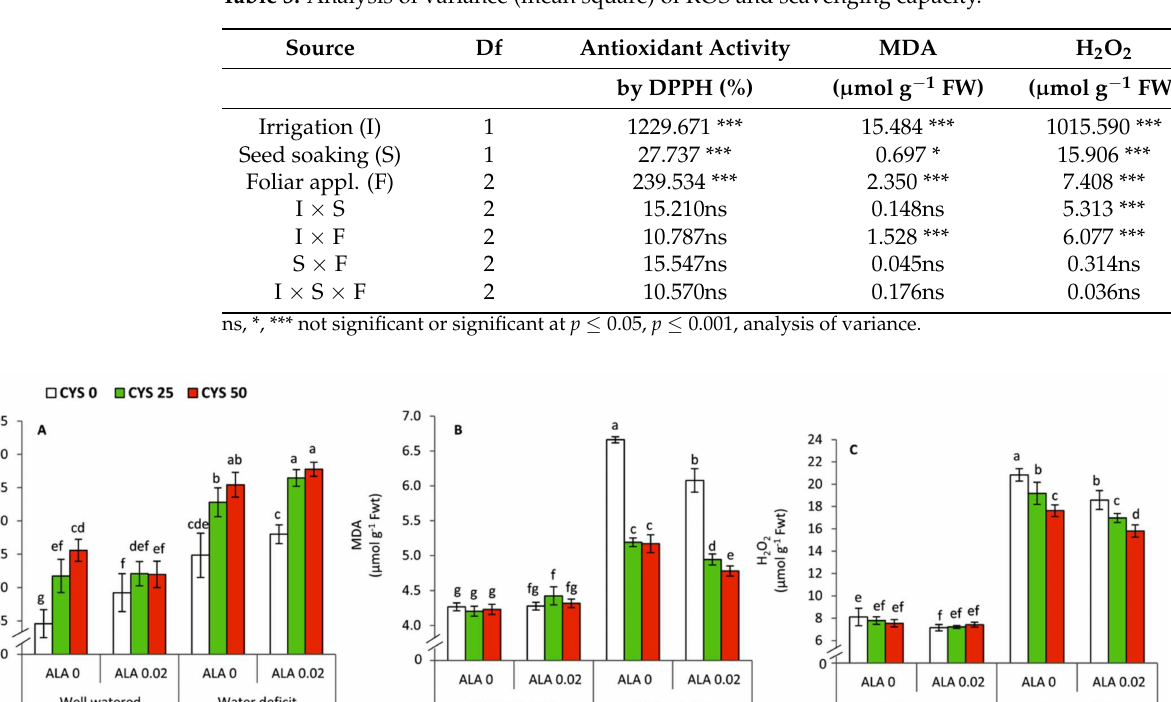
Table 3. Analysis of variance (mean square) of ROS and scavenging capacity.